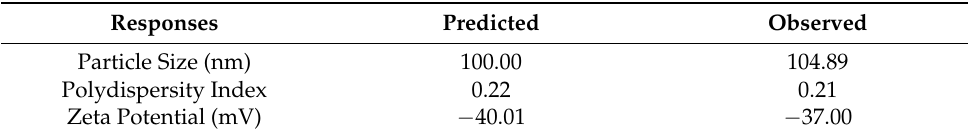
Figure 1. Response surface plots showing the effect of interaction between Compritol 888 ATO and Tween 80 composition on the ( a ) particle size, ( b ) zeta potential and ( c ) polydispersity index. Table 3. Predicted and observed response value for the optimized